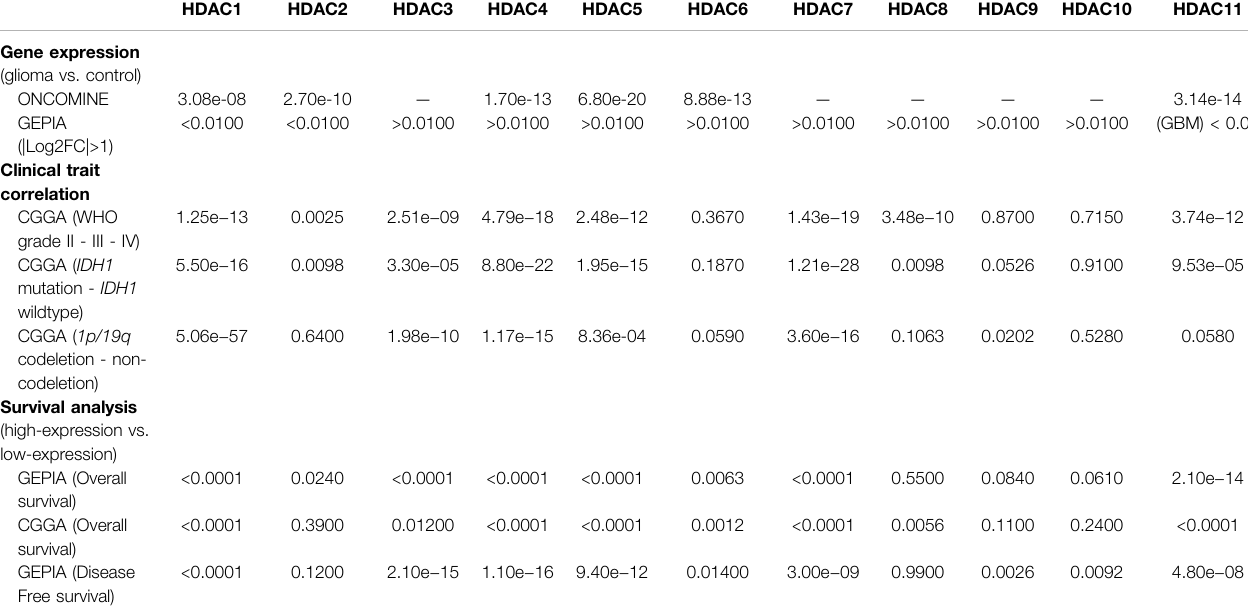
TABLE 2 | Summary of the HDAC family analysis overall result signi fi cance p